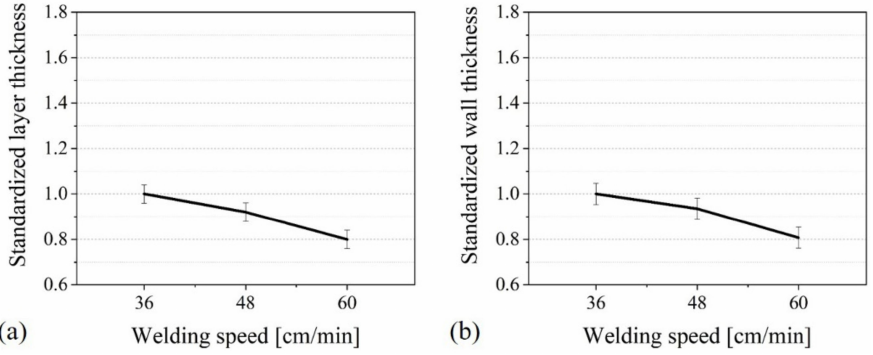
Figure 5. Effect of welding speed on layer thickness ( a ) and wall thickness ( b ) (standardized representation).